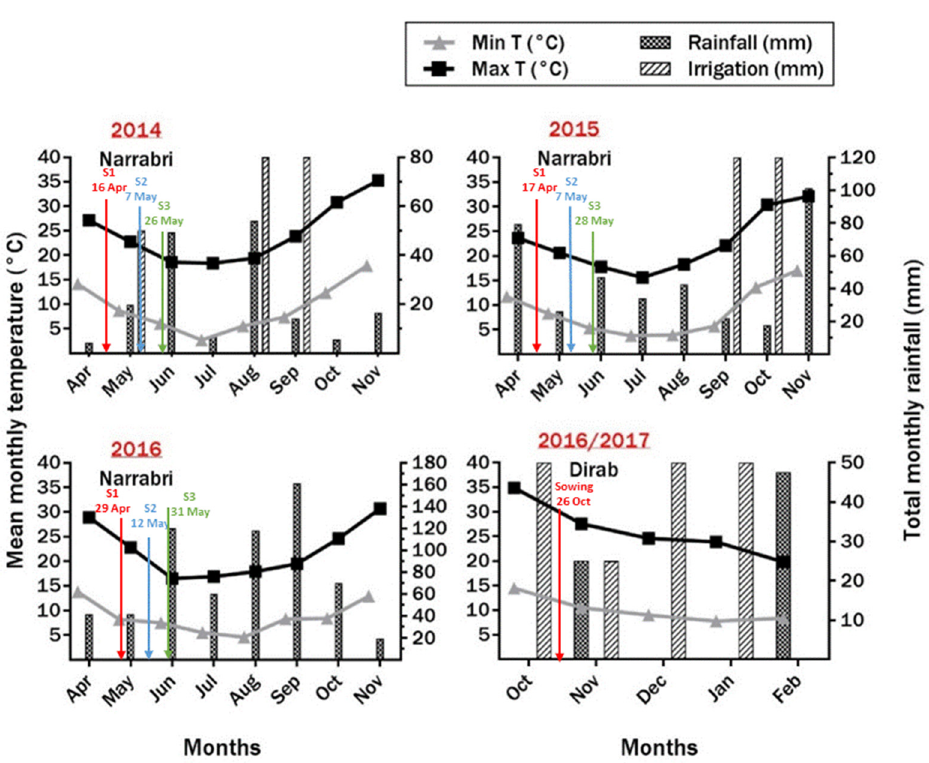
Figure 1. Date of sowing dates (sowing 1 (S1), sowing 2 (S2) and sowing 3 (S3)), mean of maximum and minimum temperatures, and total rainfall and irrigation, during the three growing seasons at the University of Sydney (Narrabri) and one season at the Agricultural Research Station (Dirab).